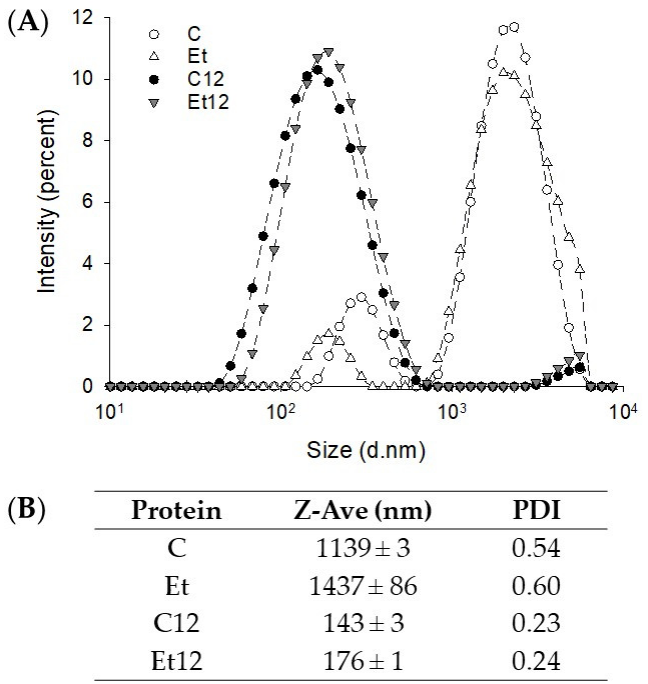
Figure 3. The intensity-diameter distribution ( A ) and Z-average diameter ( B ) of dephenoled canola protein isolate with or without pH 12 shift treatment. PDI: particle dispersion index. Samples: C: control; Et: dephenoled with 70% ethanol; C12, and Et12: pH 12 shift-treated